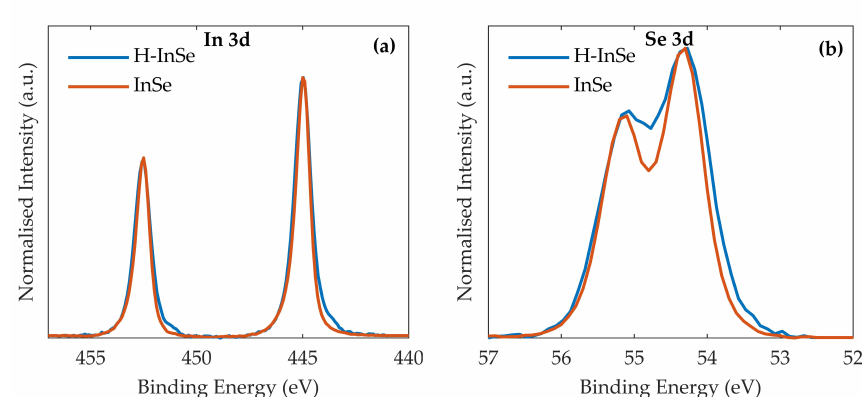
Figure 6. Charge corrected and normalised X-ray photoelectron spectroscopy (XPS) spectra for pristine and hydrogenated (32 eV) γ -InSe. Shown are the regions corresponding to: ( a ) The In 3d doublet. ( b ) The Se 3d